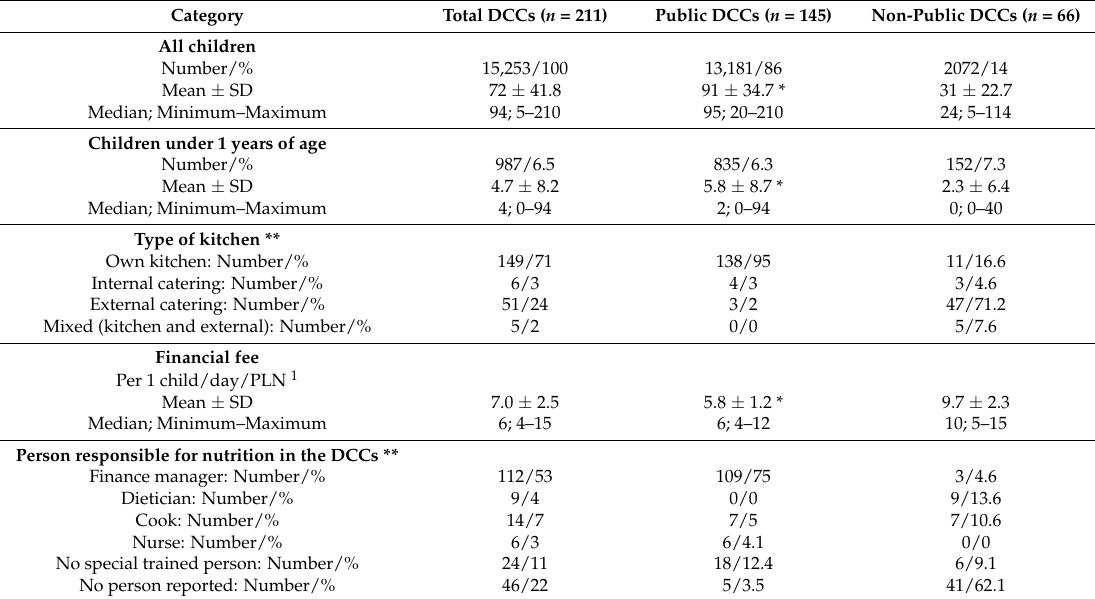
Table 1. General characteristic of day-care centers